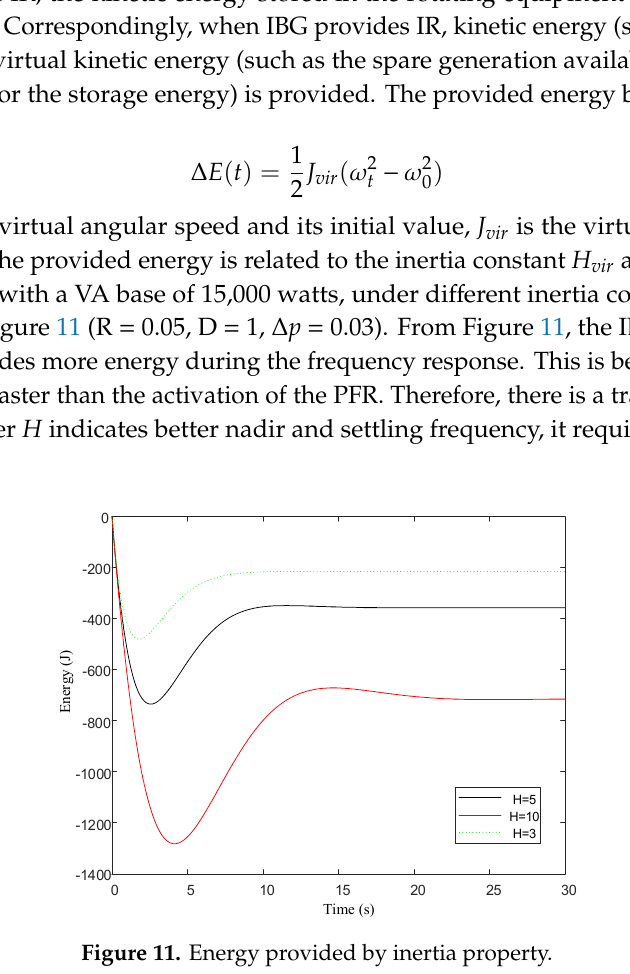
Figure 11. Energy provided by inertia property. From the previous sections, the virtual moment of inertia J vir is determined by the inertia constant H . In steady state, the settling frequency is determined by the speed droop R (when D and p Δ Figure 12. Energy provided by varying H and R at the settling time. In steady state, the provided power in the PFR loop can be expressed as